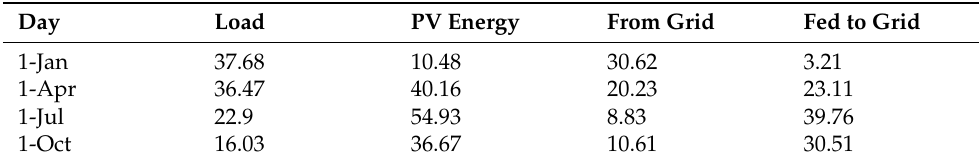
Figure 7. The daily power flows for four seasonal days. Table 2. Daily energy flow (kWh) for four seasonal